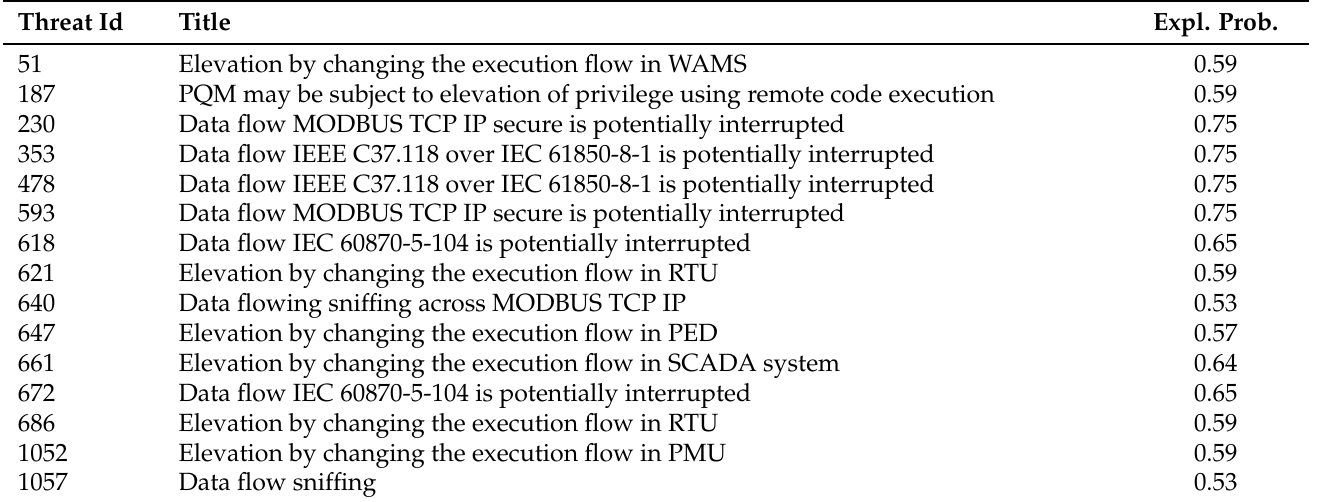
Table 5. UC3 Exploitation